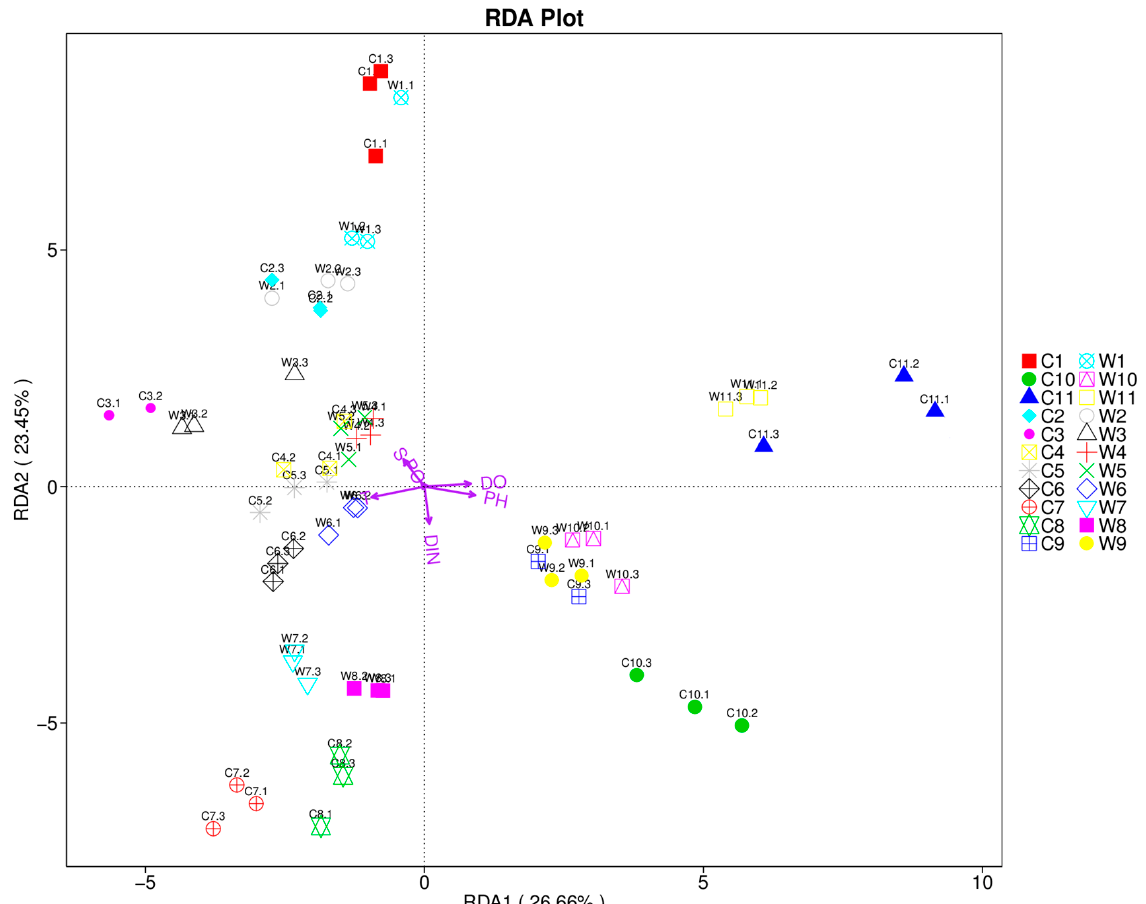
Figure 7. Redundancy analysis of environmental variables and microbial community.